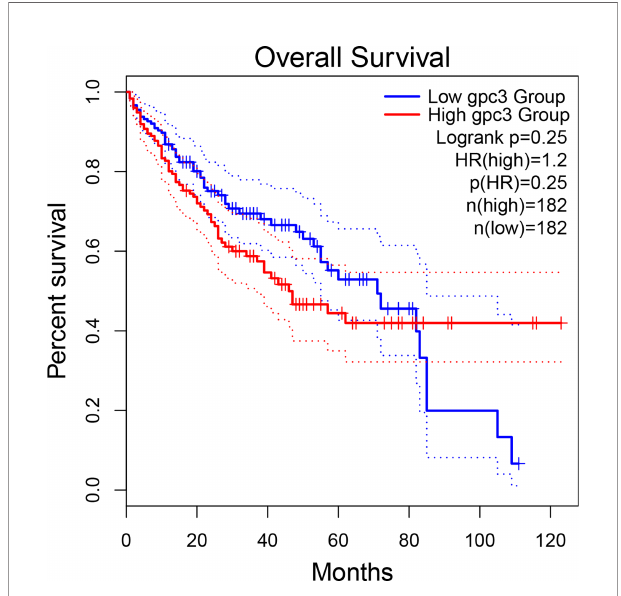
FIGURE 2 | The association between GPC3 expression and HCC